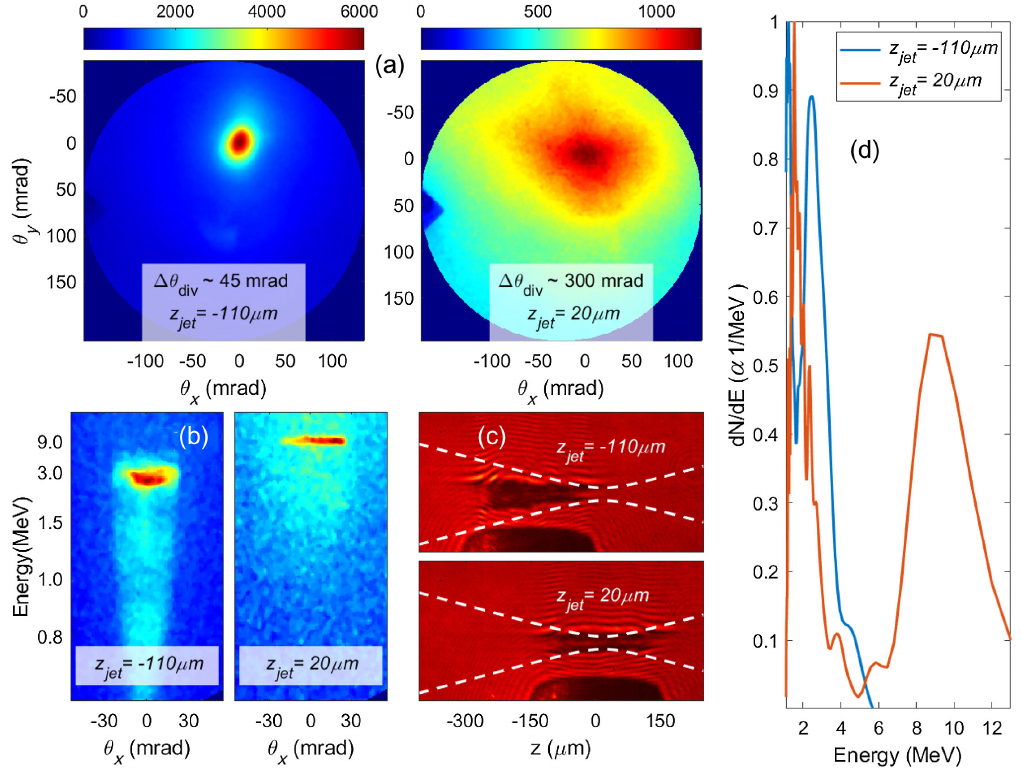
0 . 12 , ð P=P ∼ 3 . 5 . =N e; peak cr ¼ cr Þ max 20 μ m) and in the density downramp ( z − 110 μ m). jet ¼ jet ¼